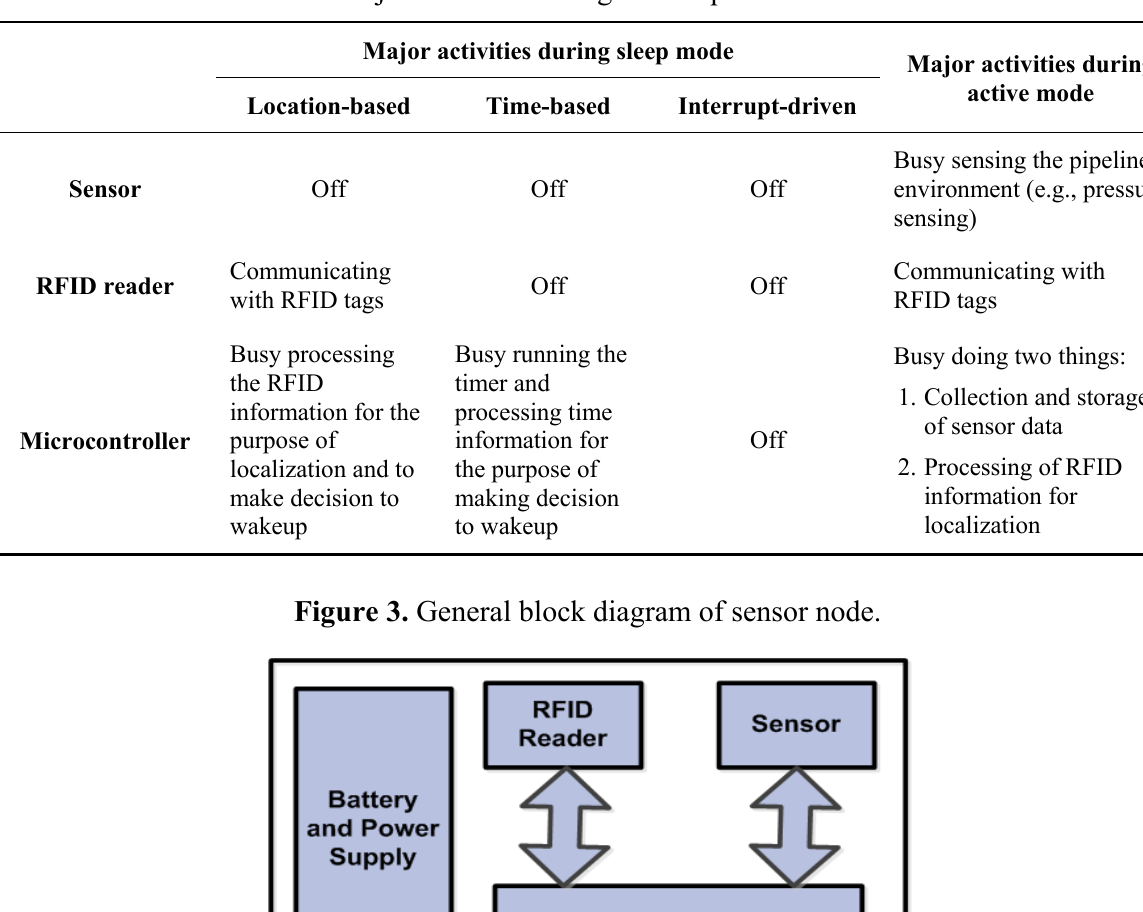
Table 1. Major activities during the sleep and active modes.